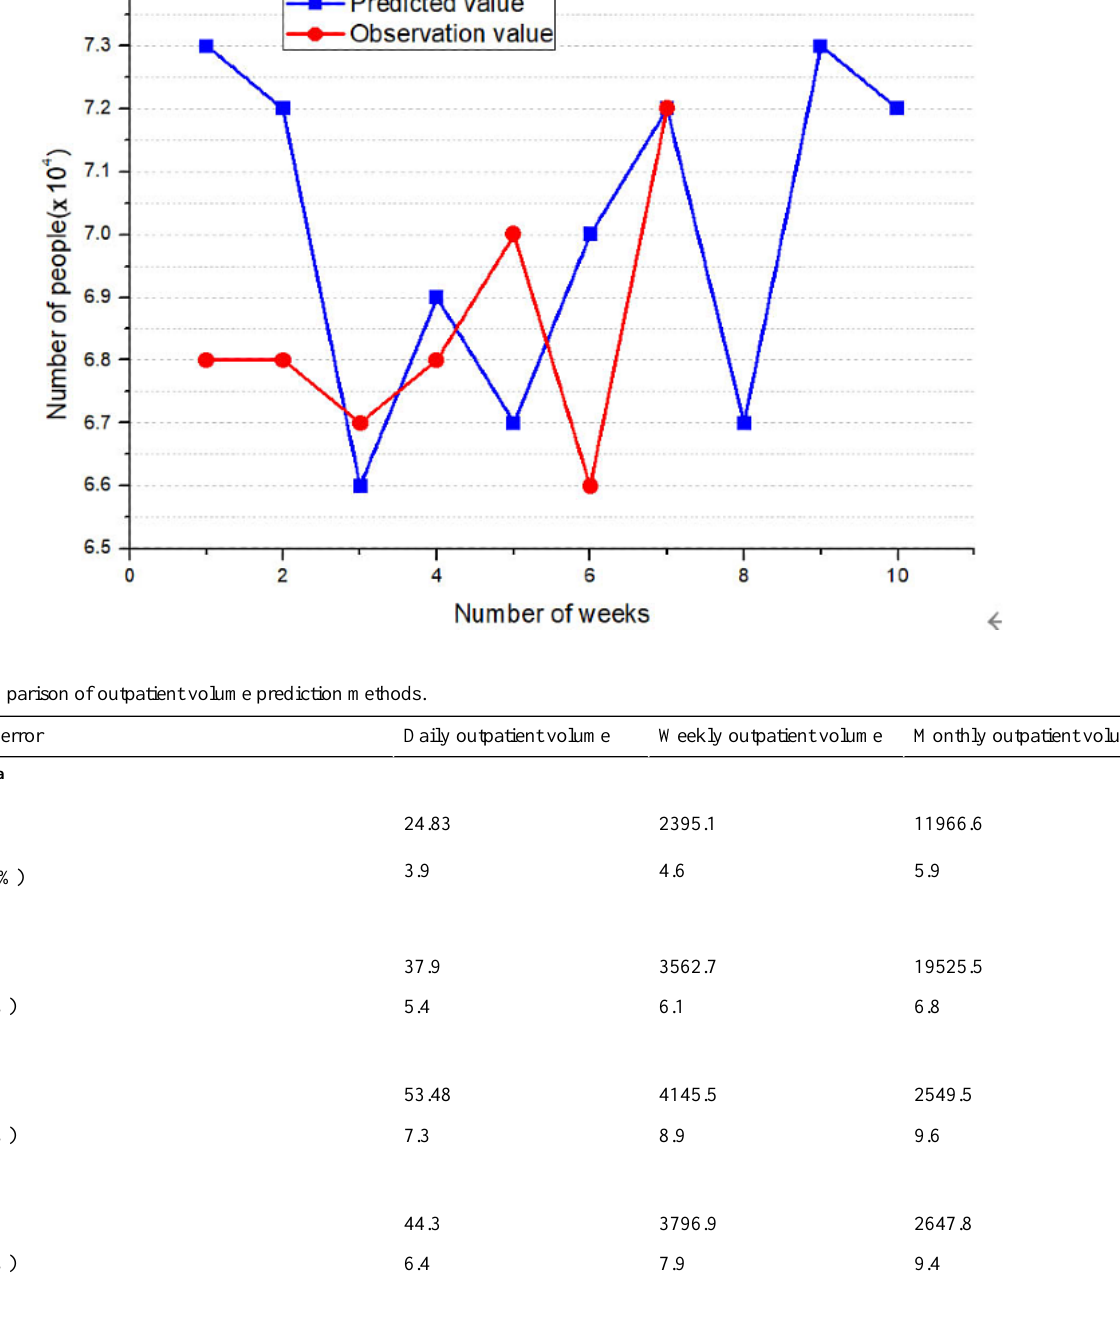
Figure 6. Weekly outpatient volume forecast results.